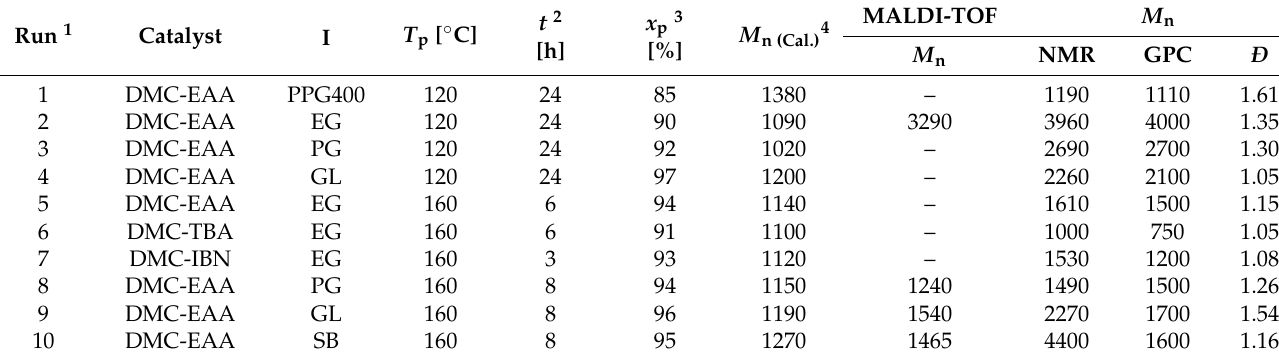
Table 2. Results for ROP of CL by DMC catalysts using various initiators